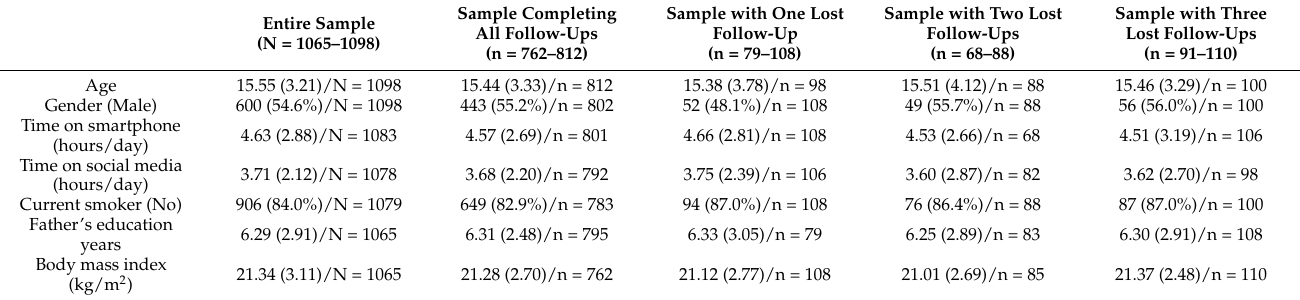
Table 1. Participant